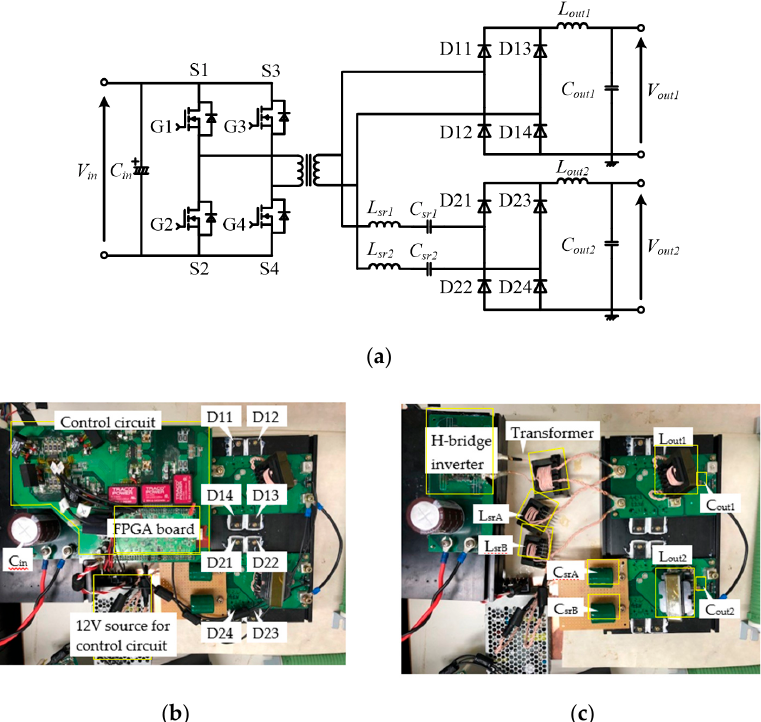
Figure 5. Experimental circuit diagram and setup: ( a ) Main circuit diagram, ( b ) Main circuit with control circuit; ( c ) Main circuit without control circuit.